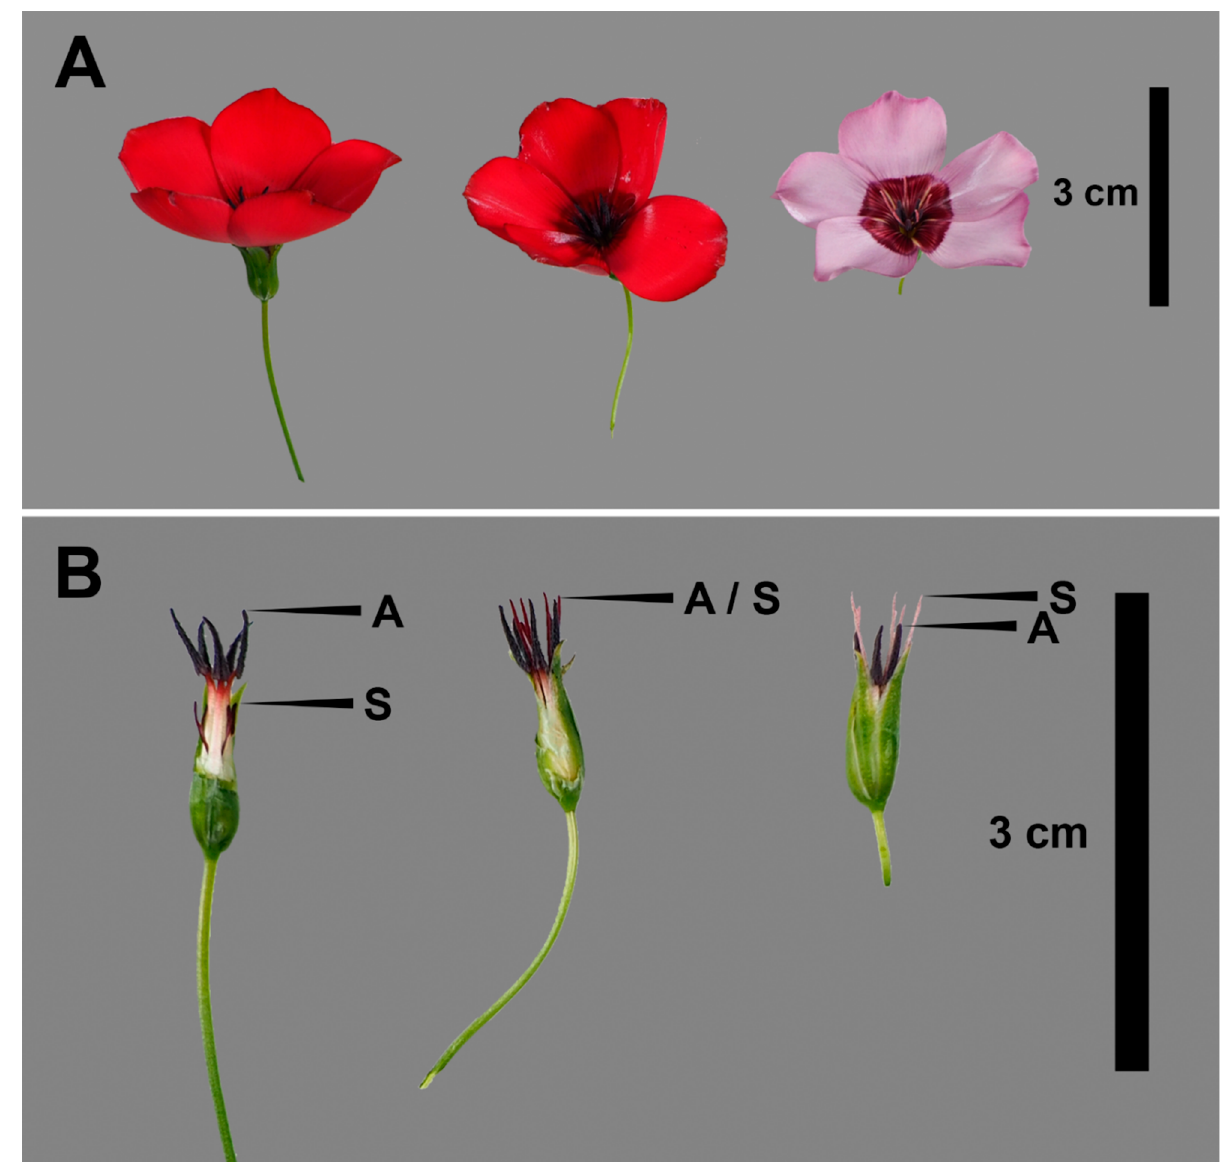
Figure 5. Flower colors and floral morphs of Linum grandiflorum : ( A ) red and pink-flowered progeny of a red × white cross (white flowered type not shown) ( B ) From left to right: thrum (short-styled), homostylous (equal length), and pin (long-styled) flower morphs. Arrows indicate relative style (S) and anther (A) lengths. Note that sepals are partially removed in the two leftmost flowers to expose the floral organs.